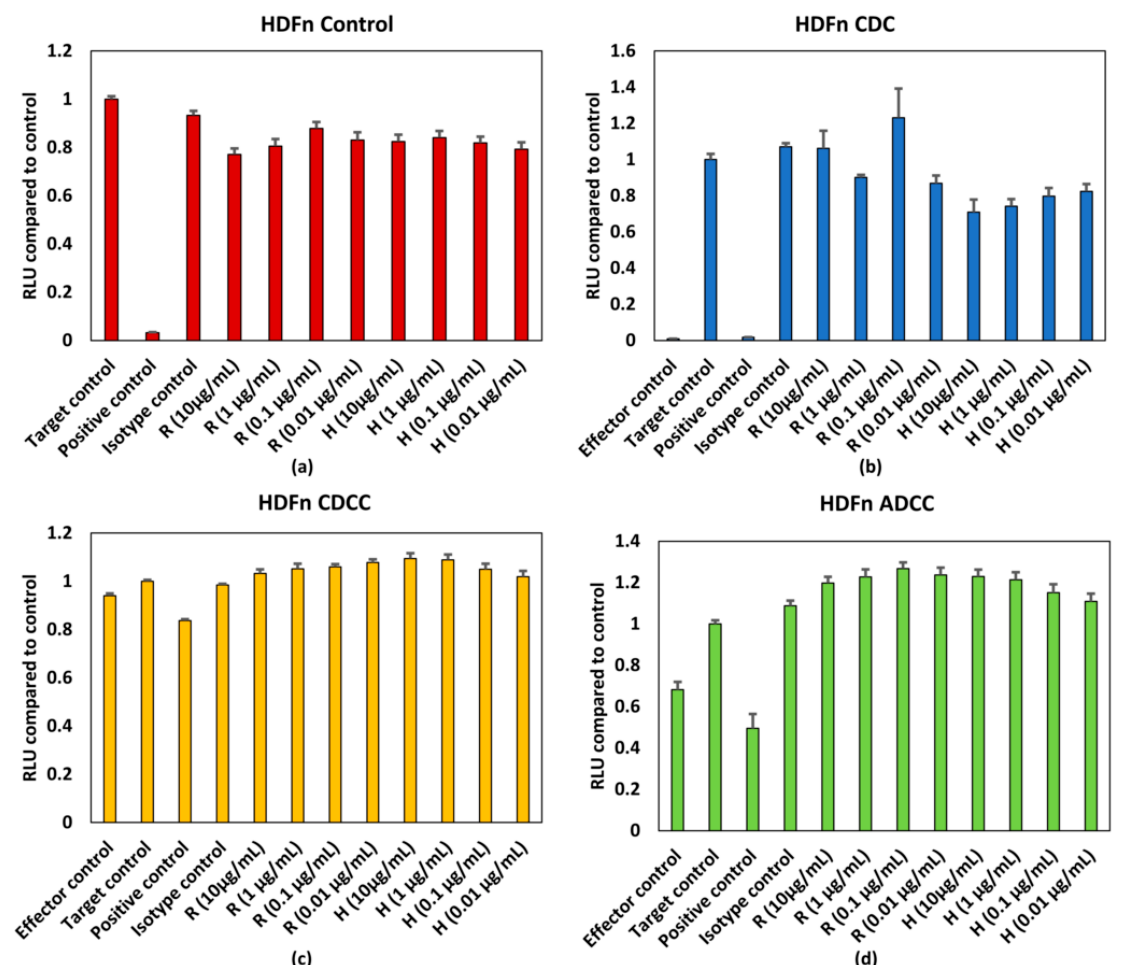
Figure 4. ( a ) Control conditions without effector cells/serum, ( b ) CDC, ( c ) CDCC, and ( d ) ADCC assay results of rituximab and Trastuzumab based on the ATP content compared to control in HDFn cells exposed to mAbs. Results represent pooled responses from four donors ( n = 4). All values expressed as relative luminescence units (RLU) compared to control (mean ± SE). R: Rituximab and H: Trastuzumab. Positive control is 5% ( v / v ) of absolute ethanol.